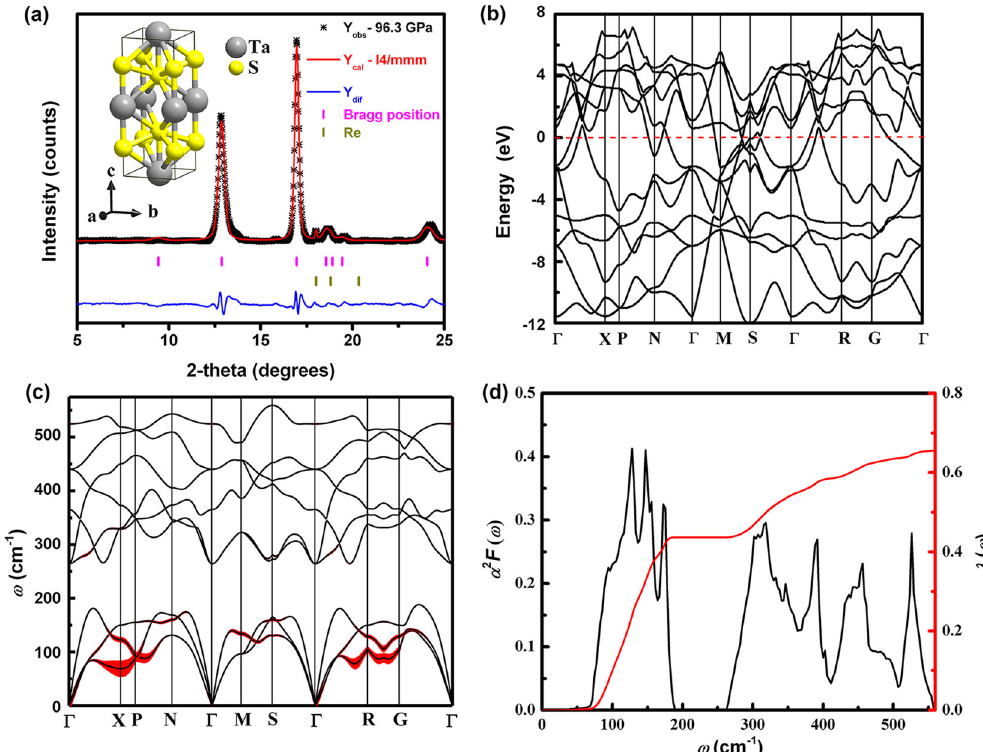
Fig. 3 Crystal structure and electronic states of I4/mmm phase. a Rietveld re fi nement of XRD data taken at 96.3 GPa using the I4/mmm structure. The inset of a shows the structure of I4/mmm TaS 2 . b Calculated band structure and c calculated phonon dispersion of the I4/mmm phase at 90 GPa. The red dashed line shows the Fermi level ( E F ). The red areas show the electron – phonon coupling (EPC), with the width proportional to the respective strength. d Eliashberg spectral function, α 2 F ( ω ) (left vertical axis), and electron – phonon integral, λ ( ω ) (right vertical